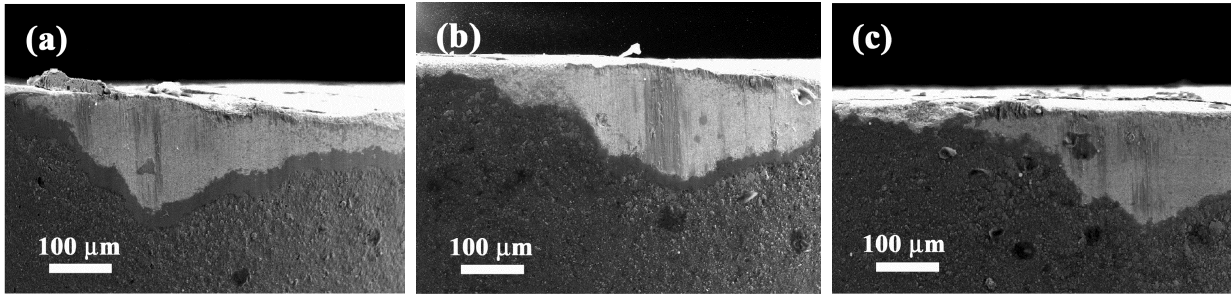
Figure 8. Flank wear patterns of cutting inserts coated with ( a ) TiN, ( b ) TiAlN, and ( c ) (Al 0.34 Cr 0.22 Nb 0.11 Si 0.11 Ti 0.22 ) 50 N 50 after interrupted milling tests against SKD11 steel with the cutting distance of 900